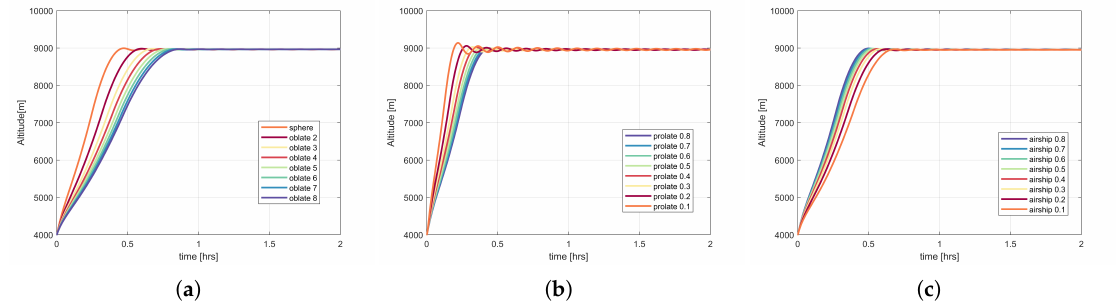
Figure 11. Altitude variation of the OZP balloons for different shapes with varying fineness ratios f in order to find the stable fineness ratio on Mars ( a ) oblate ( f : 2–8) ( b ) prolate (0.1–0.8) ( c ) airship (0.1–0.8).